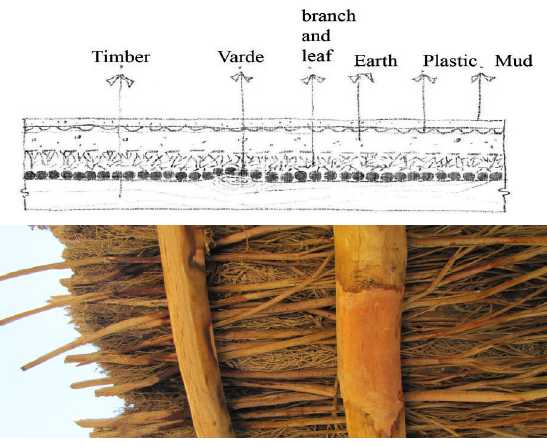
Figure 15. How does the Varde-Poosh run? In some houses, plastic is used as anisogamy, the mat is also used on wooden roofs, author.